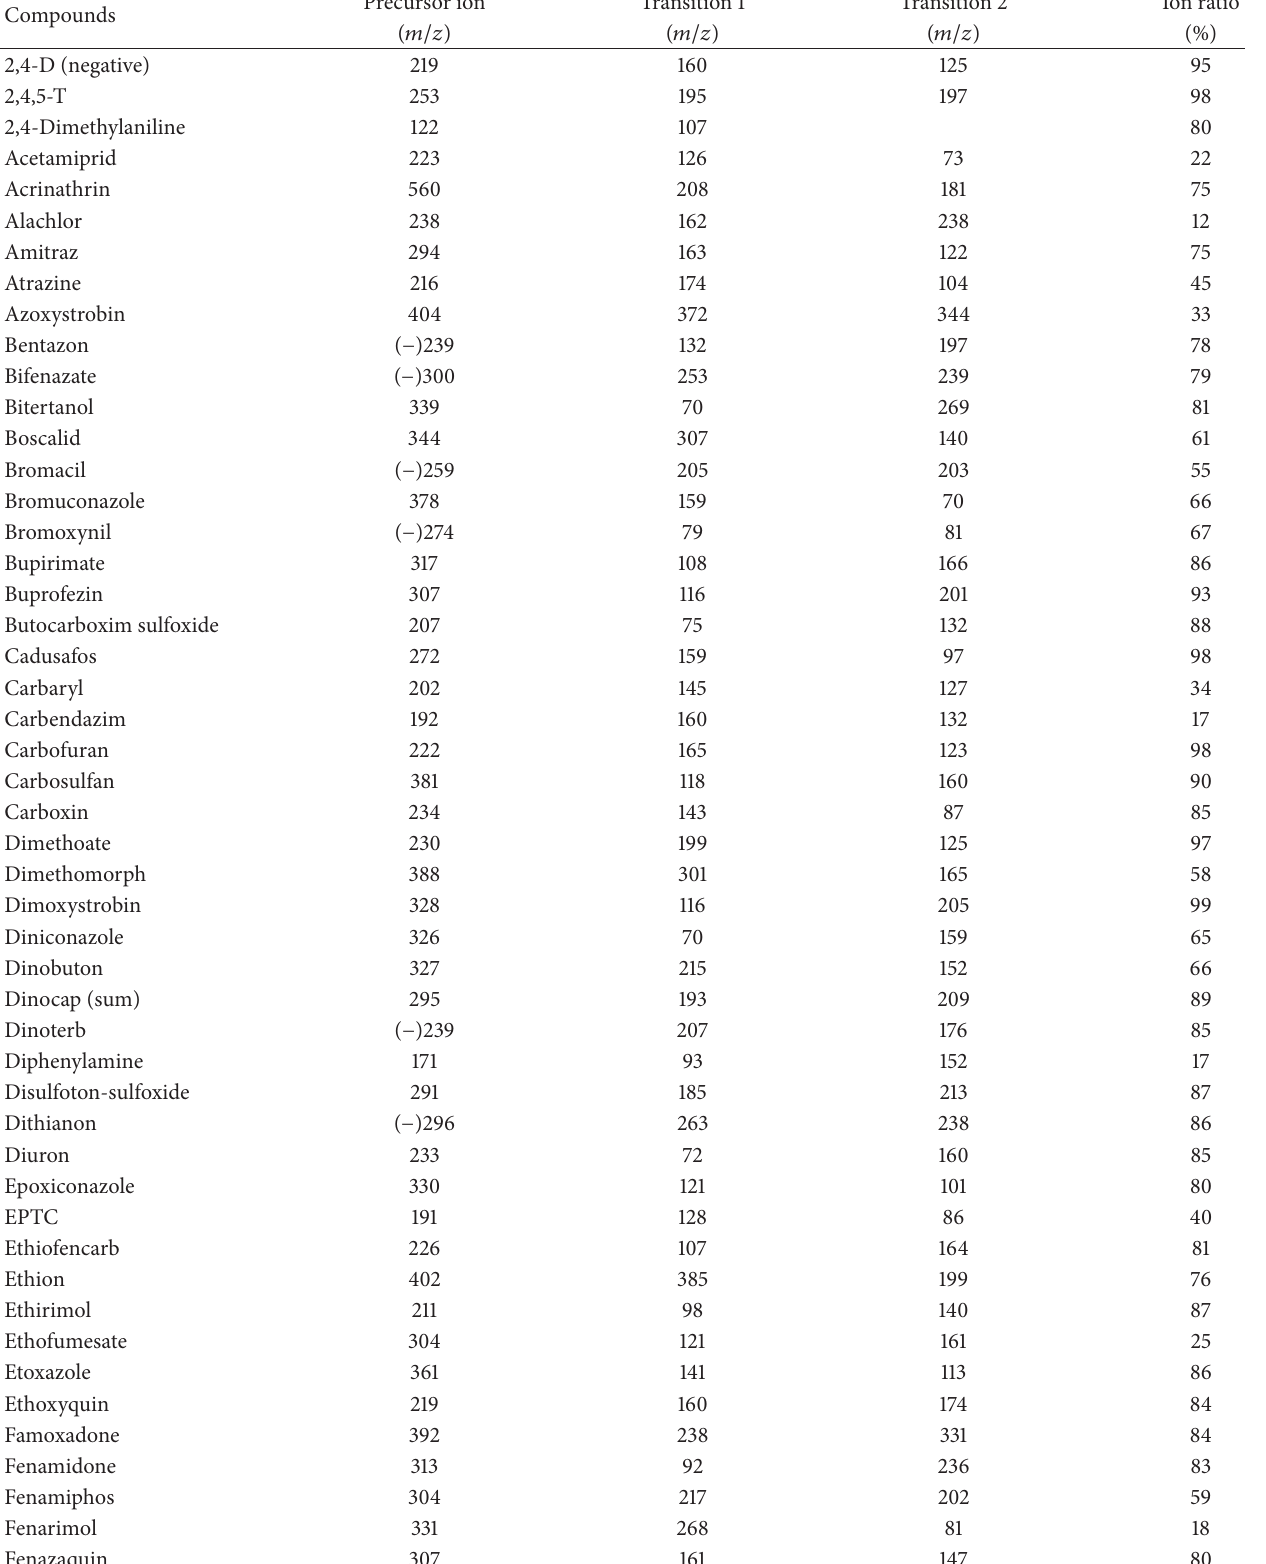
Table 1: LC-MS/MS ion